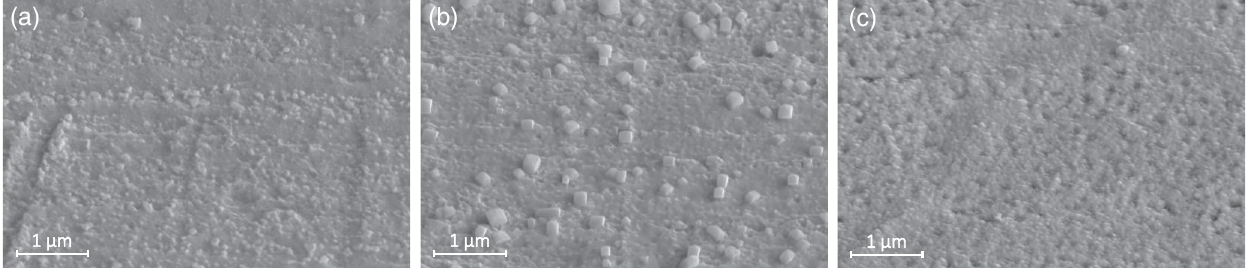
FIG. 1. Scanning electron microscopic images of (a) as received sample after hexane and ethanol cleaning, (b) load lock oxide sample after 1 day in air and (c) thick oxide sample. The pictures were taken with the electron beam impinging on the sample at 45 degres with respect to the surface normal to enhance